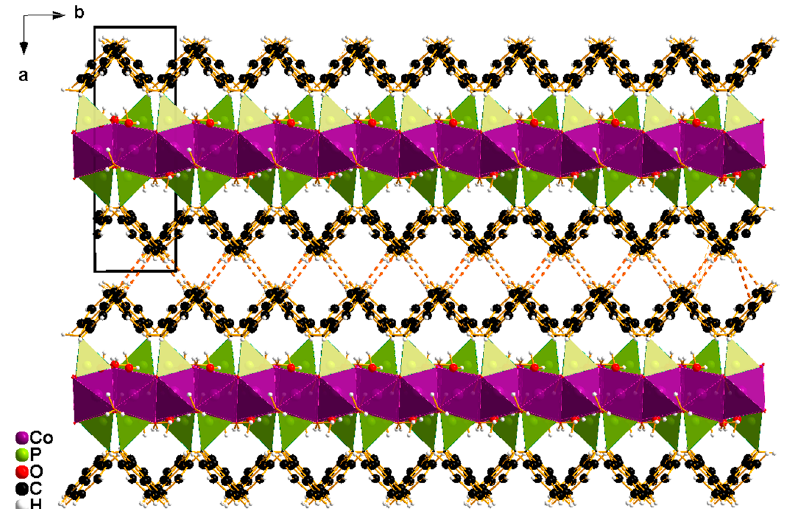
Figure 4. Projection of the structure of Co(H 2 O) 2 PO 3 C–C 12 H 9 ·H 2 O along the c axis. The black square represents the unit cell. The orange dashed lines correspond to C–H···C interactions between two organic layers with H···C distances between 2.90 Å and 3.20 Å.